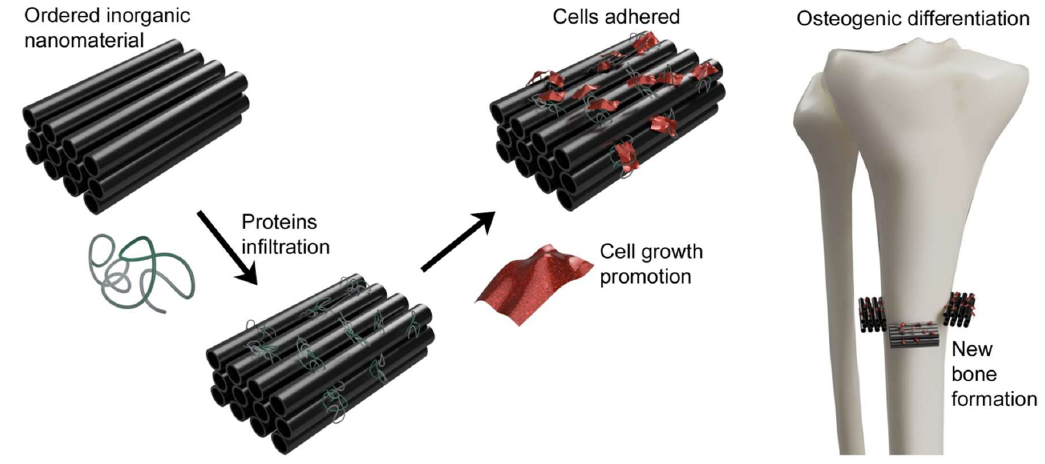
Figure 5. Scheme of carbon nanotubes absorbing specific protein, promoting bone formation.